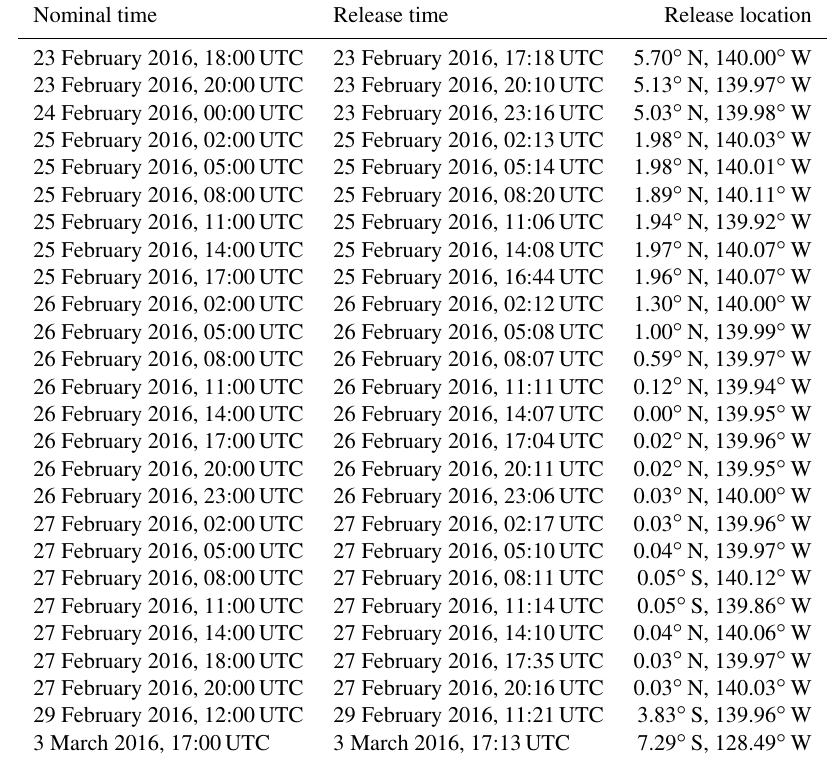
Table 2. ENRR soundings from NOAA Ship Ronald H. Brown which contain no winds due to GPS issues. Nominal